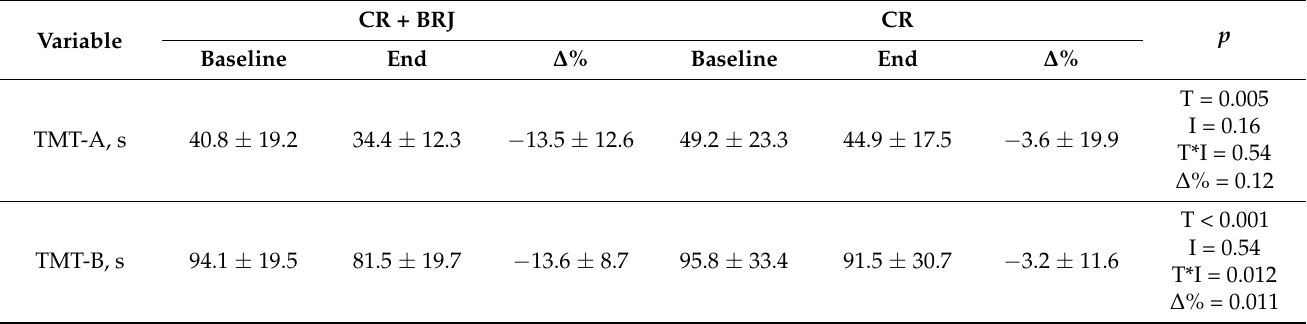
Table 4. Cognitive function.